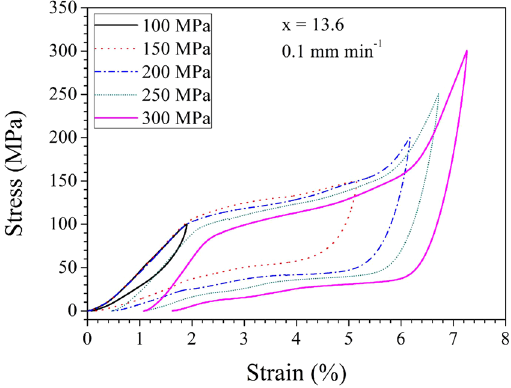
Figure 5. Isothermal stress-strain response upon cycling of Ni 45 Mn 50 − x In x Co 5 (x = 13.6) samples at a strain rate of 0.0003 s − 1 (0.1 mm min − 1